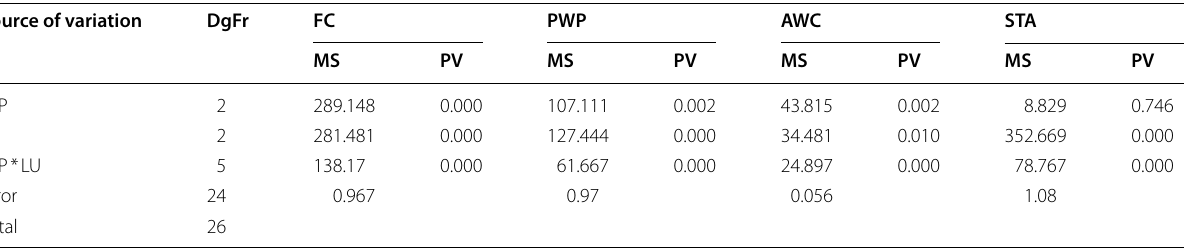
MS is the mean square, PV is p-value, DgFr is the degree of freedom